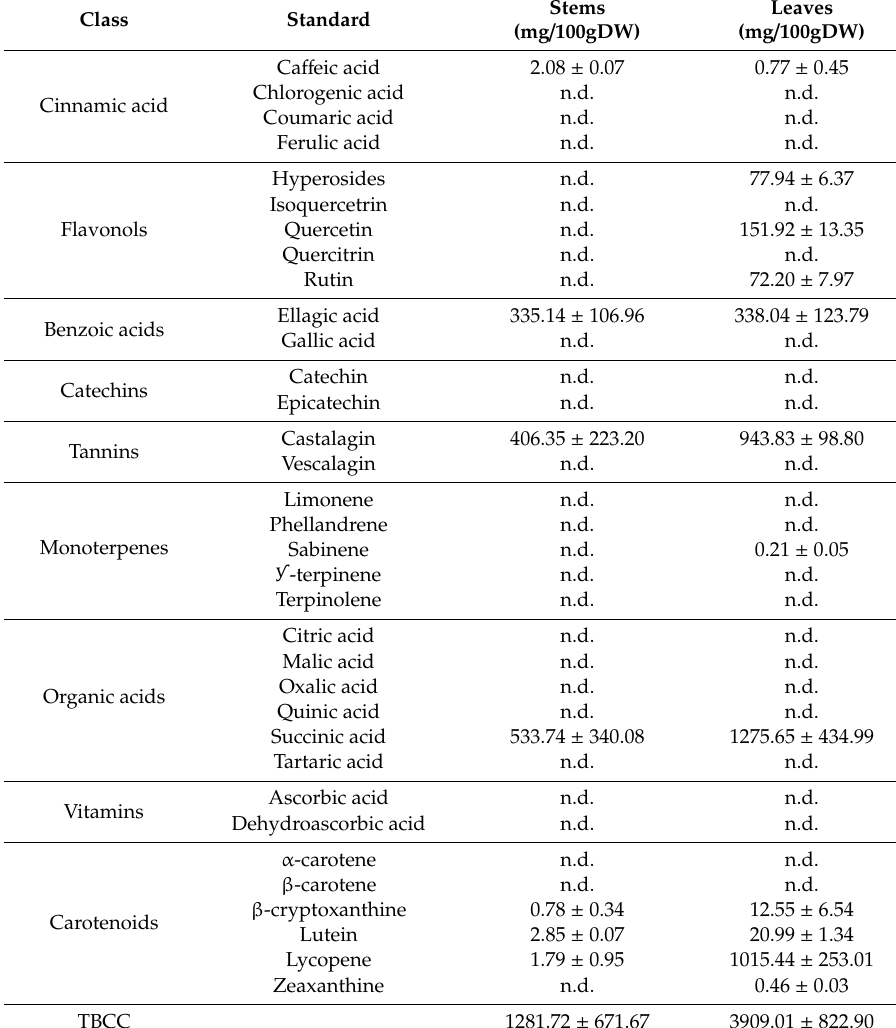
Table 1. Phytochemical fingerprint of analyzed